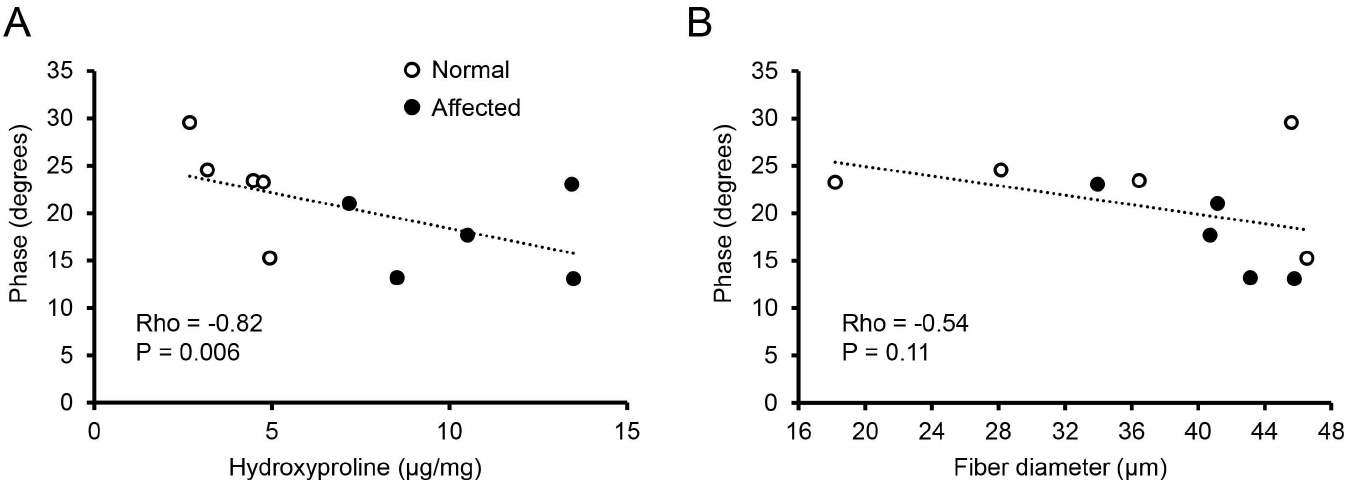
Fig 6. Spearmananalysis of correlation between the EIM data and disease status. (A) Correlationbetweenphaseat 150 kHz and the hydroxyproline content. (B) Correlationbetweenphaseat 150 kHz and the myofiber diameter. Rho and p values are marked for each correlationanalysis. Open circle, normaldogs; closed circle, affected dogs. Each circle representsone